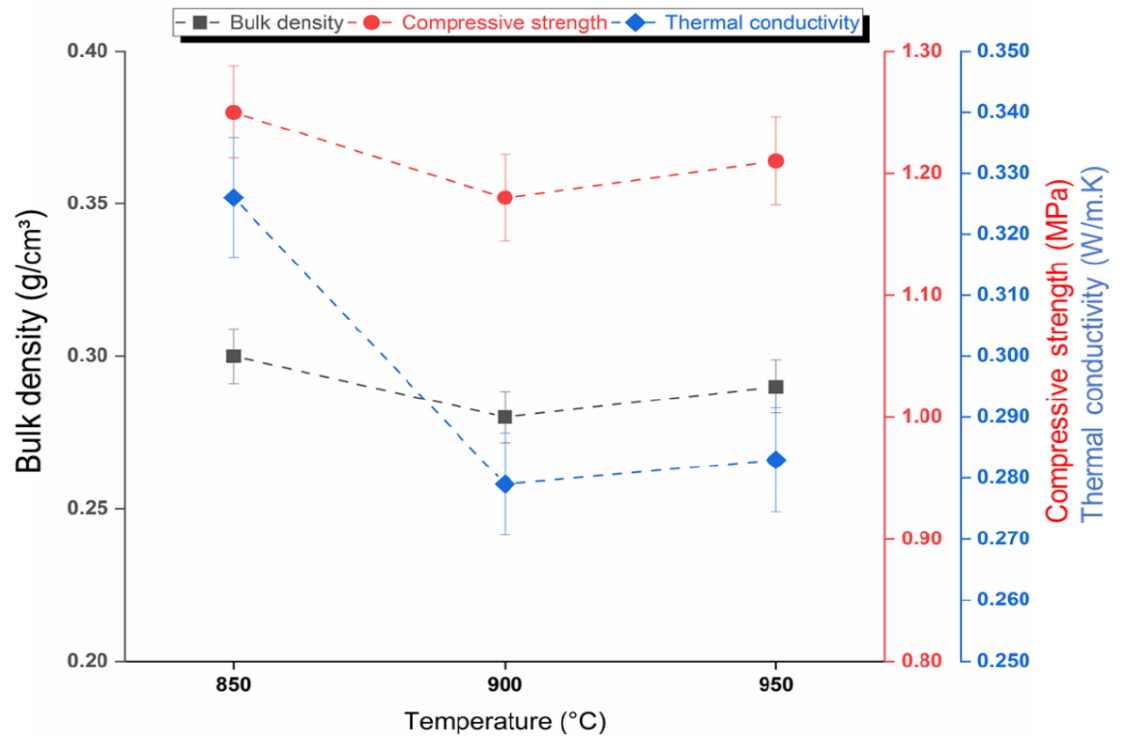
Figure 6. Bulk density, compressive strength, and thermal conductivity of the sintered foams: 850, 900 and 950 °C.